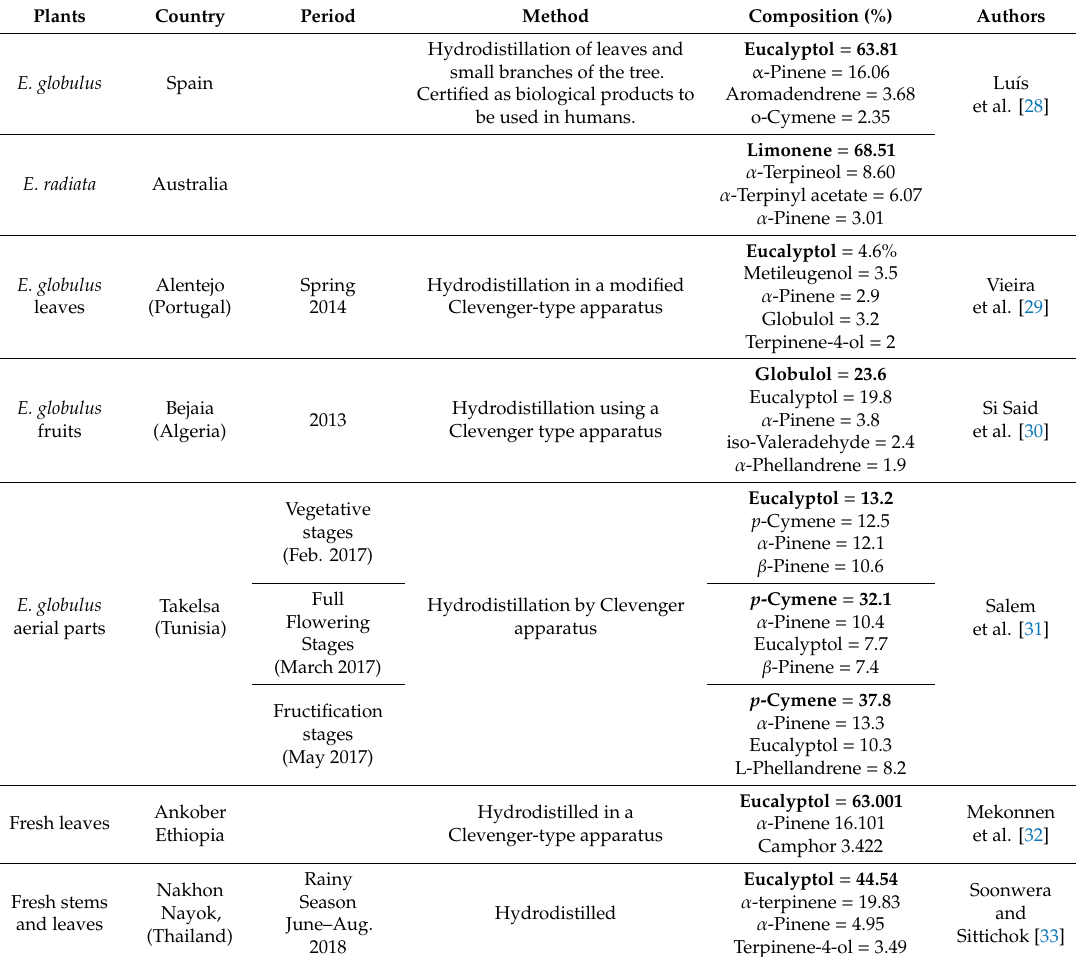
Table 5. Comparison of the chemical composition of Eucalyptus essential oil from di ff erent countries.